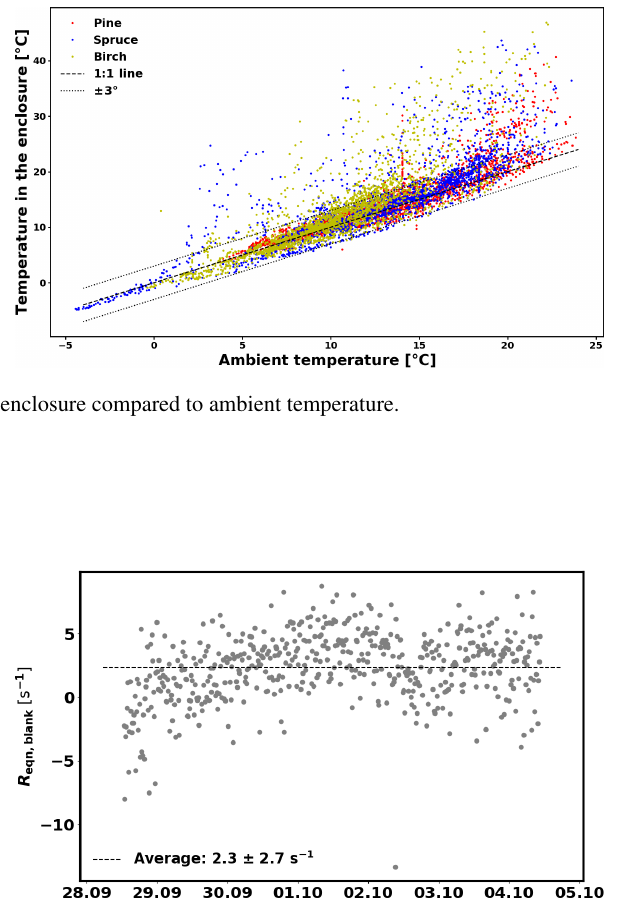
Figure C2. R eqn , blank measured from an empty branch